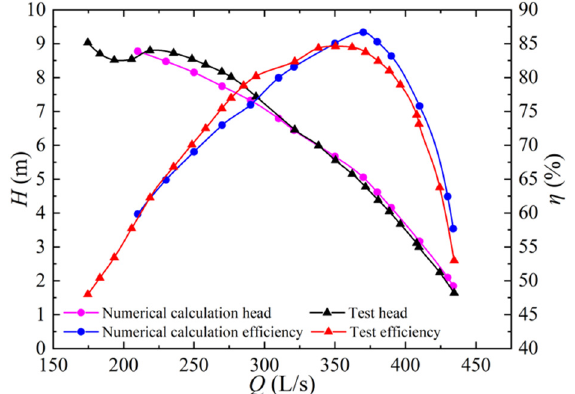
Figure 4. Comparison of the numerical calculations and experimental energy performance results.